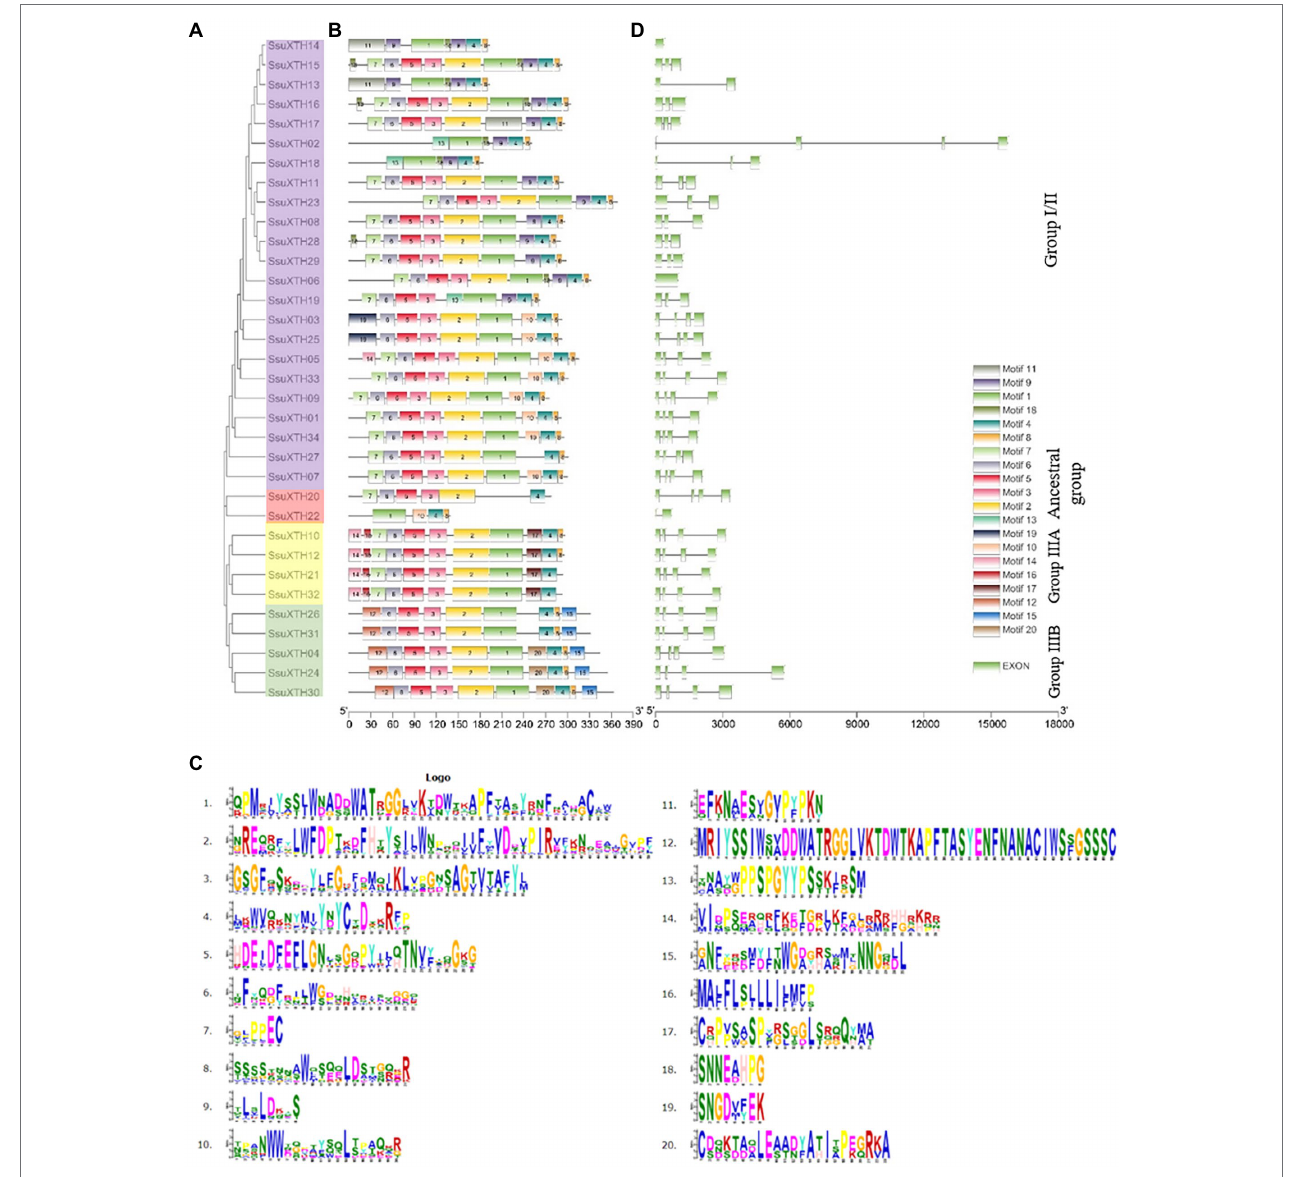
FIGURE 2 | Evolutionary analysis, motif compositions, and gene structures of 34 SsuXTHs. (A) The phylogenetic tree of SsuXTHs, and four different groups are indicated by different background colors. (B) The motif location in SsuXTHs. (C) The gene structures of SsuXTHs. (D) The legend depicting the protein sequence of the corresponding